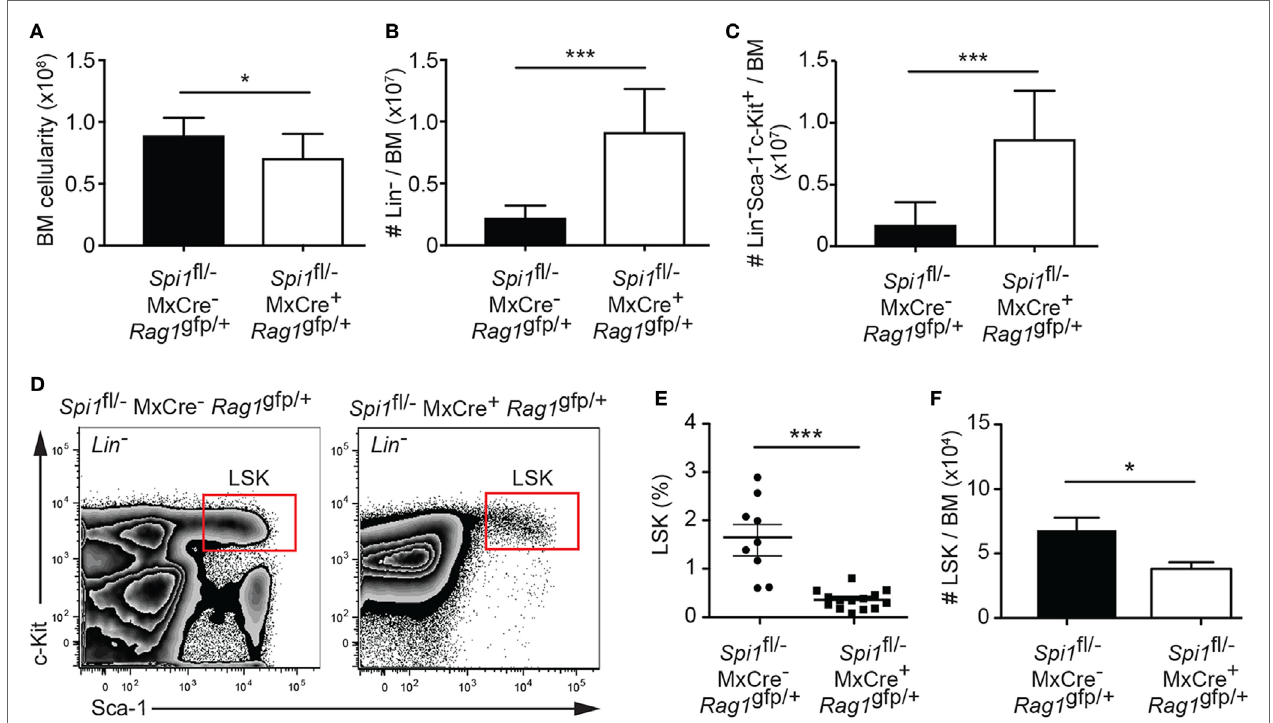
FigUre 1 | Reduced numbers of hematopoietic progenitors from PU.1 conditionally deficient bone marrow (BM). Spi1 fl/ − MxCre − Rag1 gfp/ + and Spi1 fl/ − MxCre + Rag1 gfp/ + mice were injected with polyIC on days 0 and 3, and analyzed by flow cytometry on day 14. Graph shows (a) the absolute cell numbers in the BM (2 × femur and tibia), (B) the number of Lin − cells, and (c) the number of Lin − Sca-1 − c-Kit + cells in BM preparation. (D) Representative flow cytometry plot of Lin − BM preparations from the mice of indicated genotypes. Boxes indicate the position of the LSK populations. (e) Graph shows the proportion of LSK cells in Lin − BM preparation. Each dot represents an individual BM sample. Horizontal line shows the mean ± SD. (F) Absolute LSK cell numbers in the BM. Data in the graphs are the mean cell number ± SD from between 9 and 14 mice per genotype. p Values compare the indicated groups using an unpaired t -test. * p < 0.05, *** p <